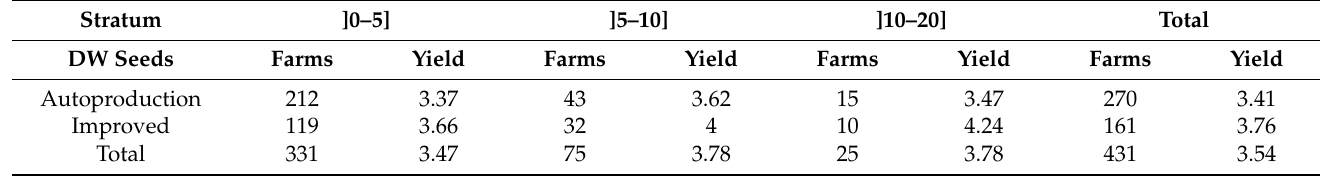
Table 8. Average DW yields in ton sorted by stratum and quality of